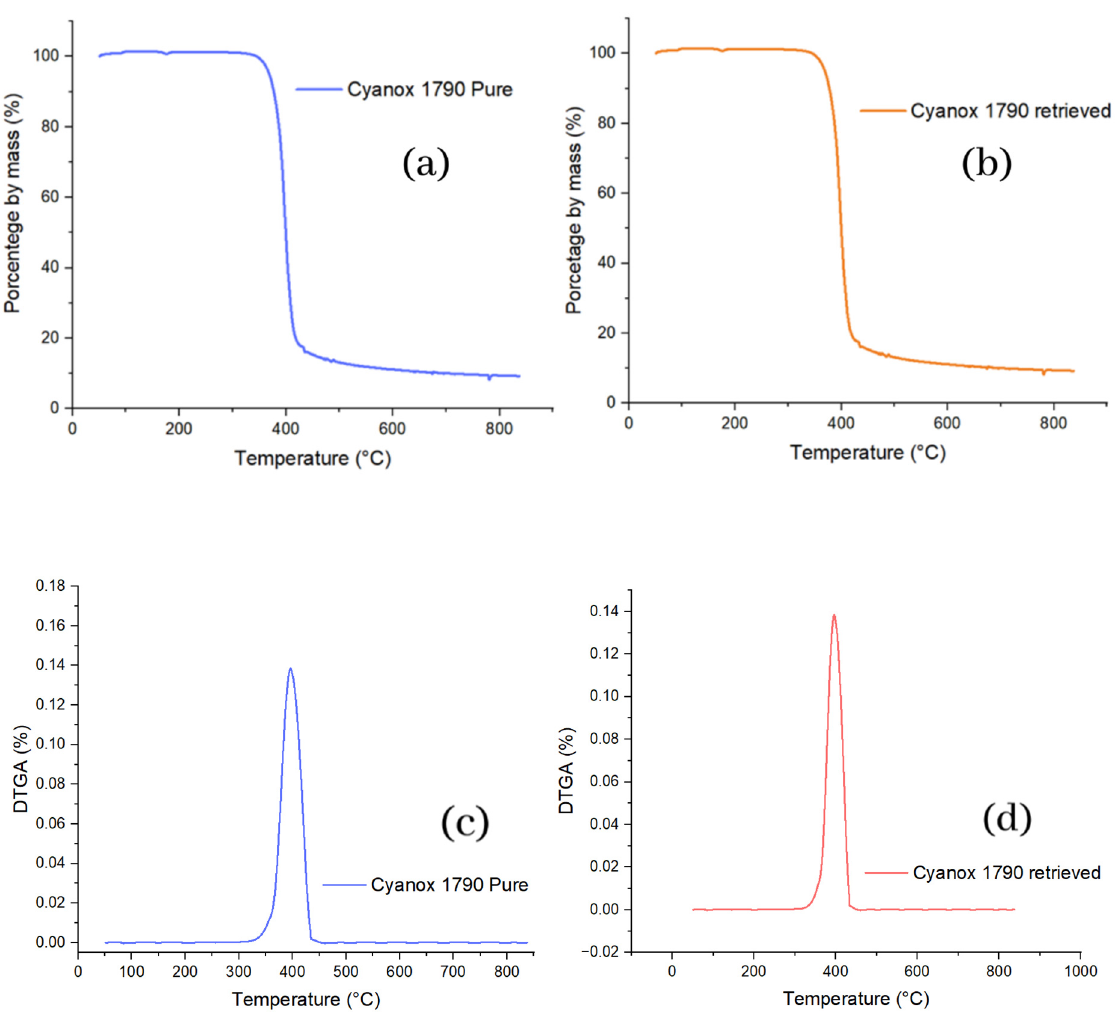
Figure 5. ( a ) TGA graphics of pure and ( b ) recovered Cyanox 1790 and ( c ) DTGA Cyanox 1790 pure and ( d ) recovered.